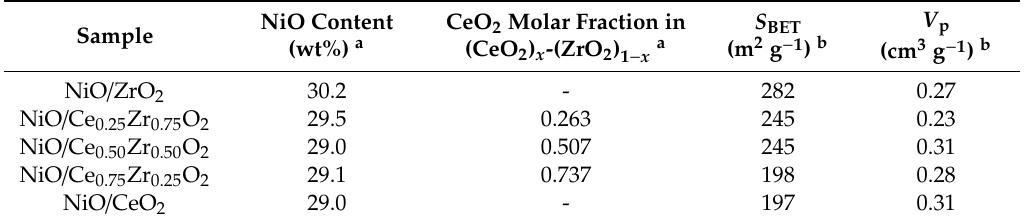
Table 1. Chemical composition and textural features of the NiO / Ce x Zr 1 − x O 2 samples.